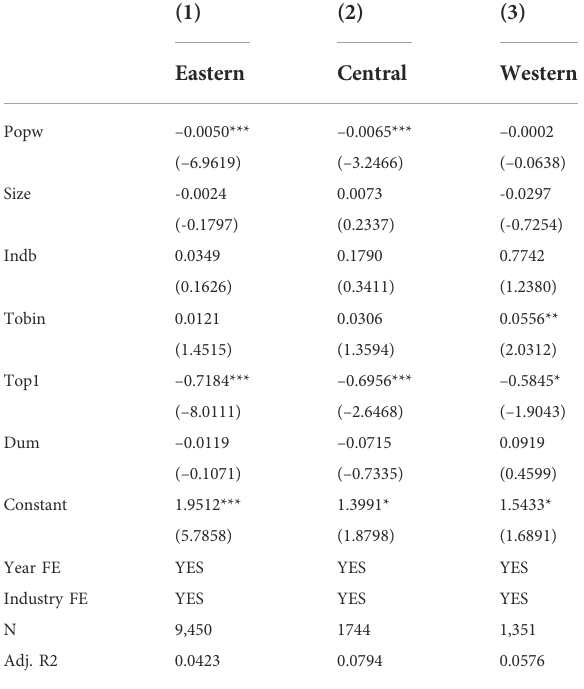
TABLE 9 Regression results of company regional heterogeneity. TABLE 10 Regression results of company ownership